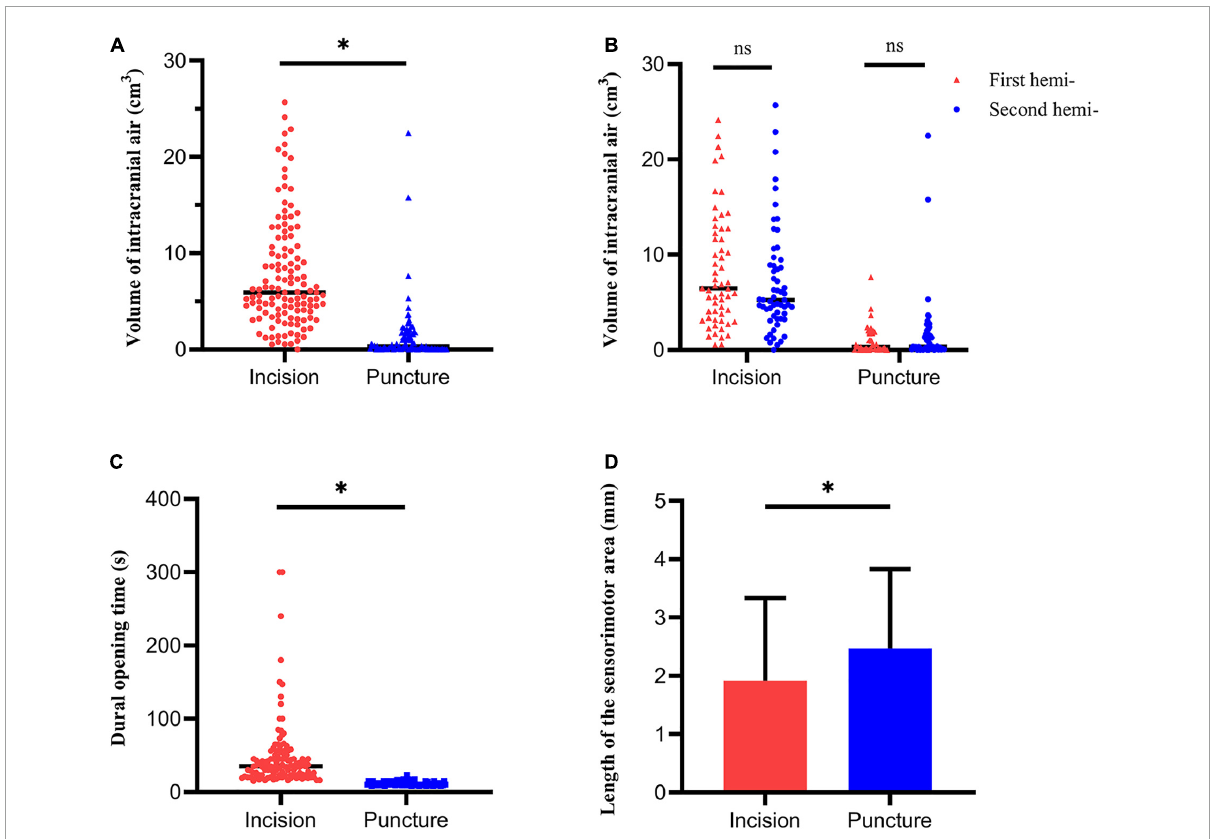
FIGURE3 Pneumocephalus, dural opening time and MERs outcomes. (A) The volume of intracranial air significantly differed between the dural incision and dural puncture groups. (B) The volume of intracranial air showed no significant difference between the first and the second hemisphere. (C) Dural opening time significantly differed between the dural incision and dural puncture groups. (D) Length of the sensorimotor area significantly differed between the dural incision and dural puncture groups. Hemi-, hemisphere; ∗ P < 0.05; ns, no